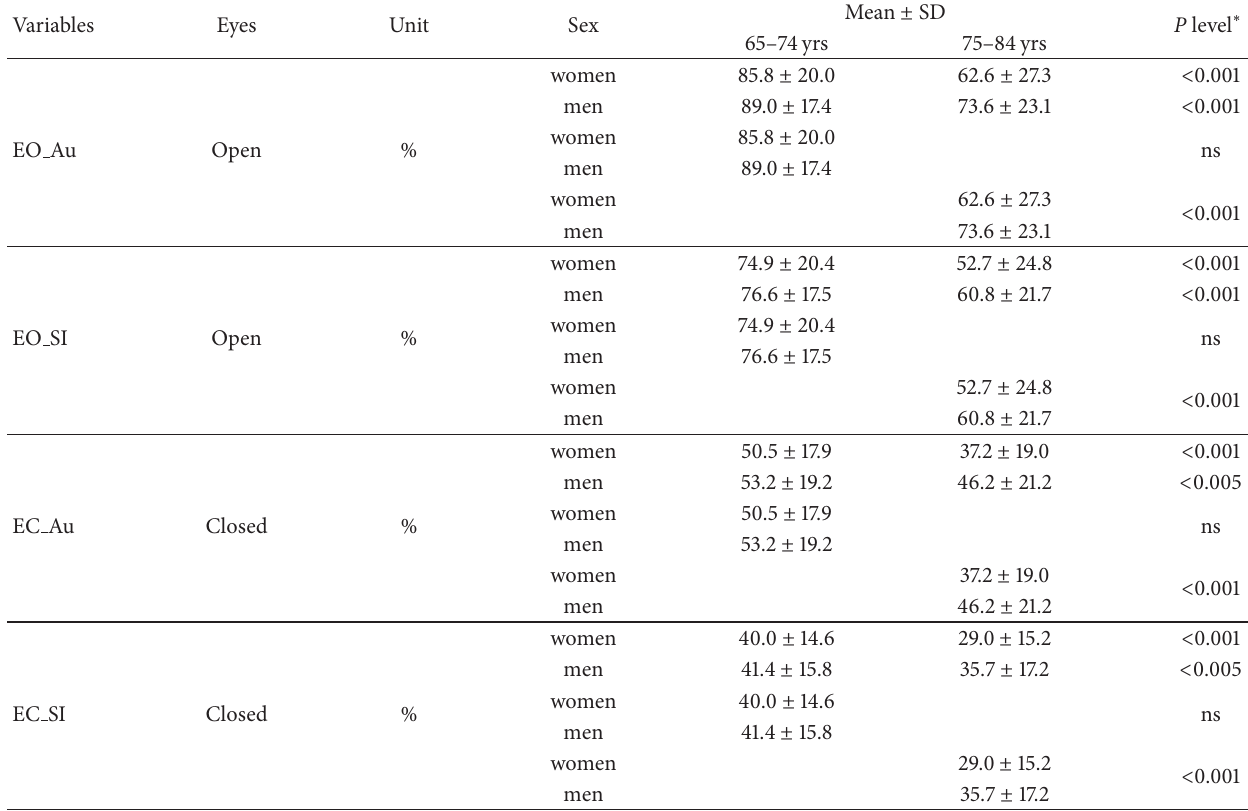
Table 2: The results of the single stance test (ST). Each variable in the first column is identified by a compound name which includes the eye condition and the name of the basic